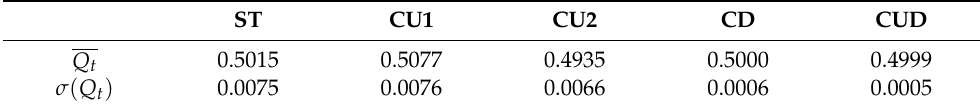
Figure 9. The variation of instantaneous flow rate Q t at the left outlet with dimensionless time. For all cases, β = 0.5, Wi = 5. The results in the dimensionless time range of 300 to 400 are an example to illustrate the approximate periodic waveform. Table 5. Statistical results over the last 700 dimensionless time. Q t and σ ( Q t ) are the mean and standard deviation of Q t ,